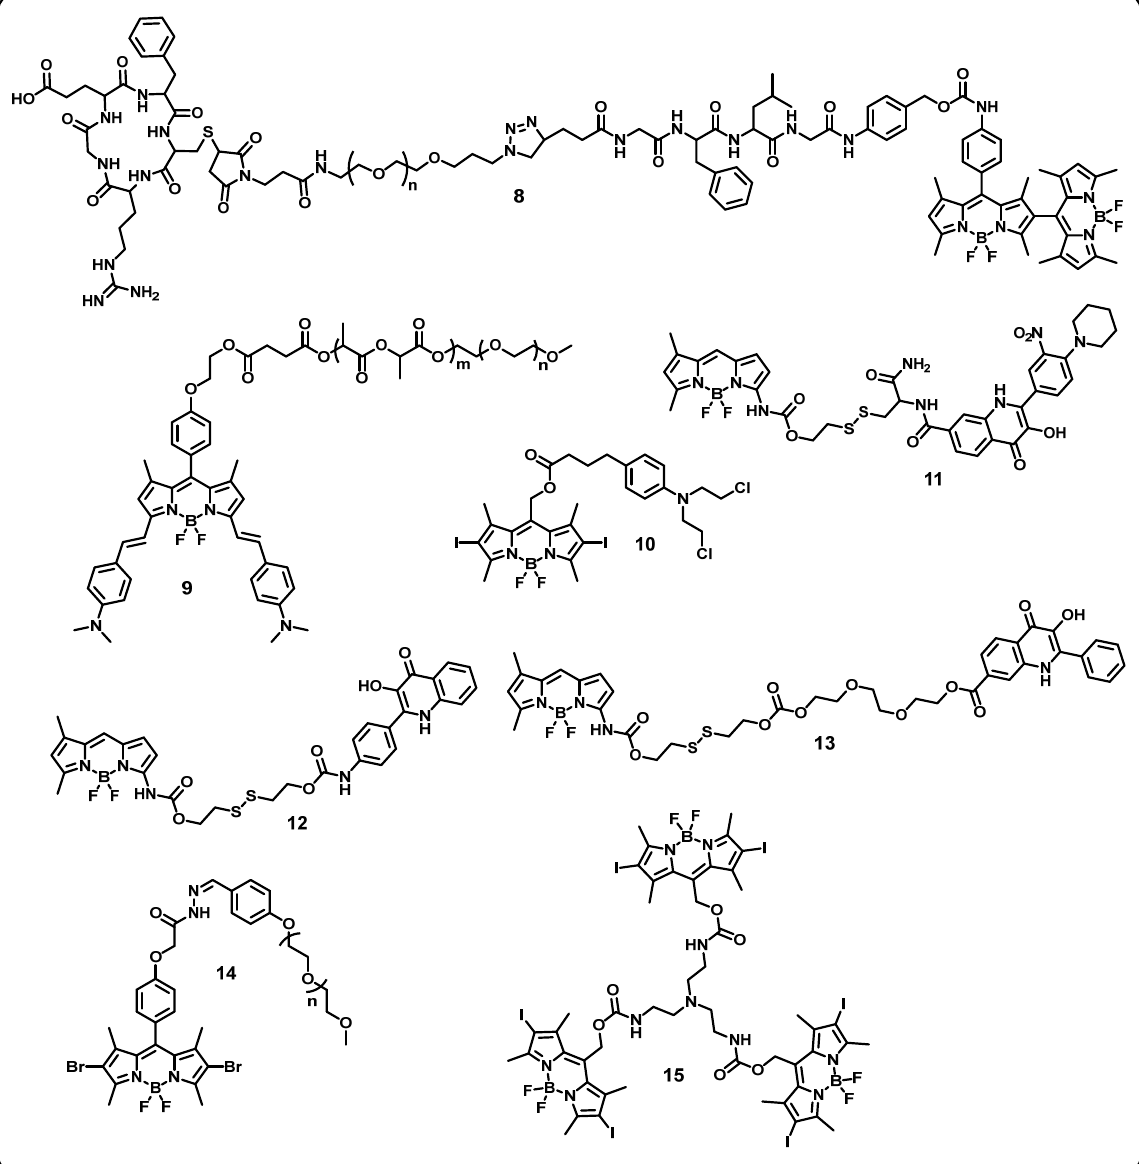
Figure 11. Structure of BODIPY derivatives ( 8 – 15 ).